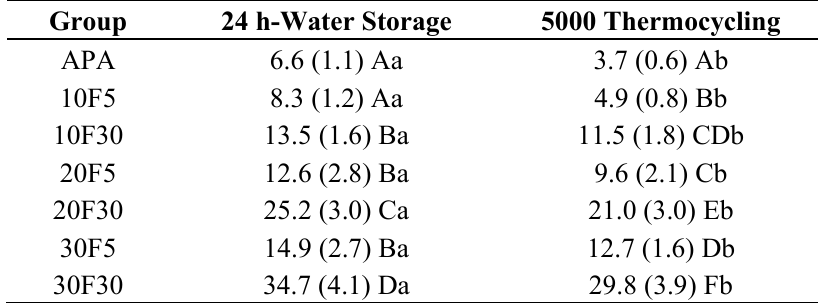
Table 3. Resin shear bond strength of the zirconia ceramic specimens subjected to different surface treatments before and after thermocycling (mean (standard deviation) in